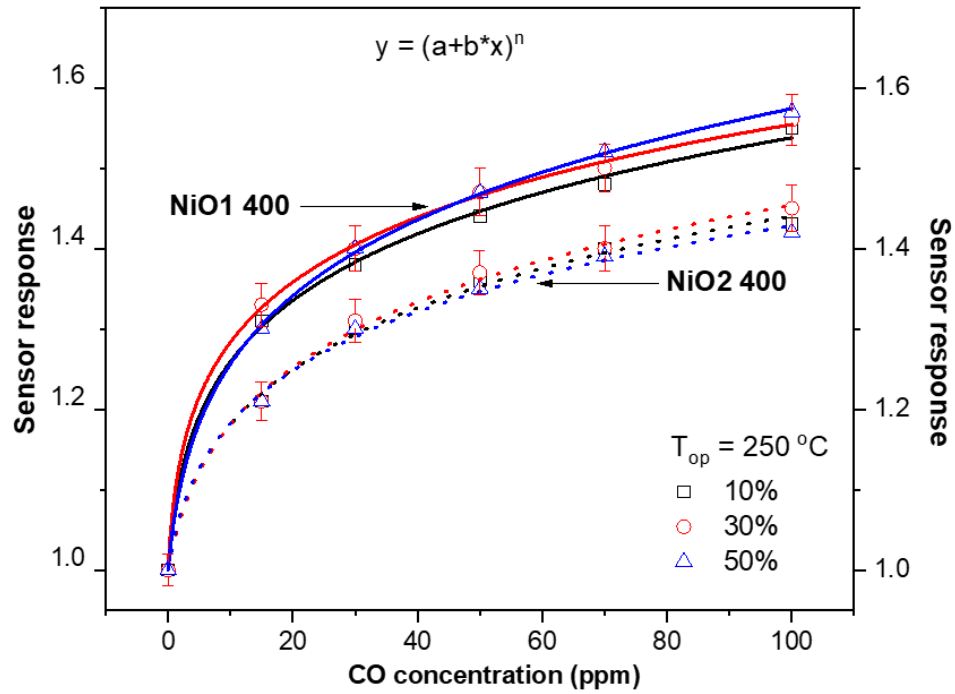
Figure 6. Sensor response for NiO1 400 and NiO2 400 when operated at 250 °C and exposed to 10–100 ppm of CO with 10–50% RH in the background atmosphere.